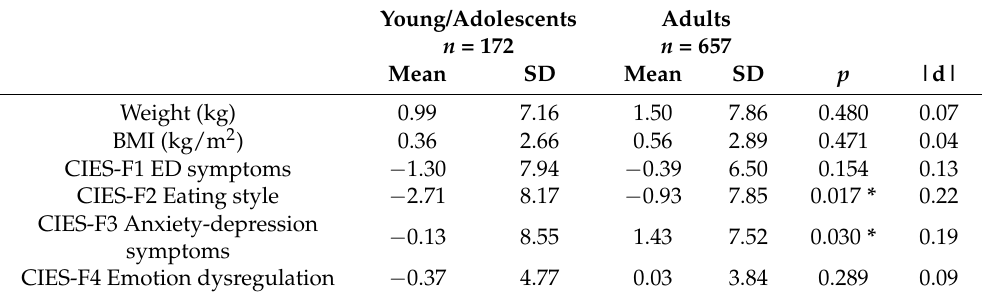
Table 4. Comparison of the post-pre differences by the groups of age.